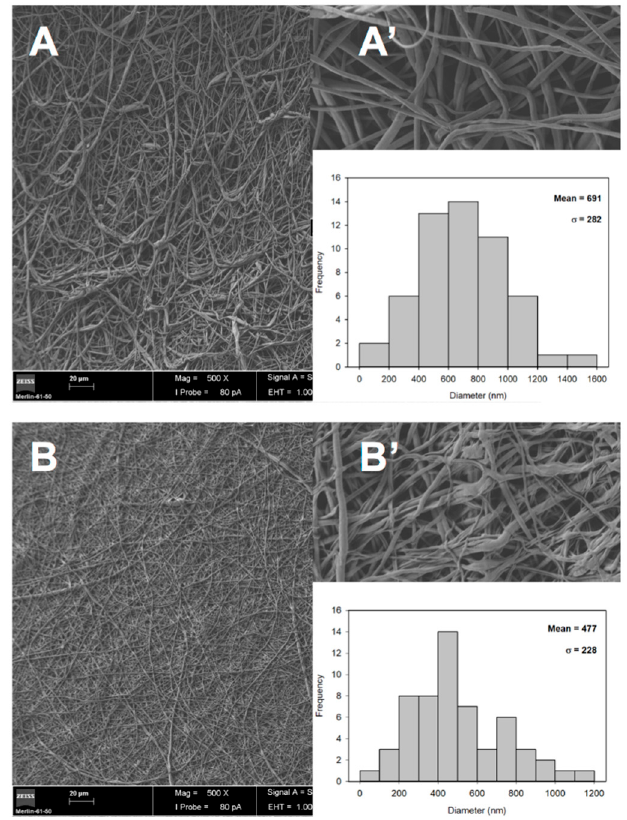
Figure 4. SEM images of the surface morphology of the PCL/PLA ( A , A’ ) and GelMA/ChMA ( B , B’ ) electrospun fibers Magnifications: 1000× (main figures) and 10,000× (inserted figures). The inserted graphics represent the individual measurements of the fiber diameters.